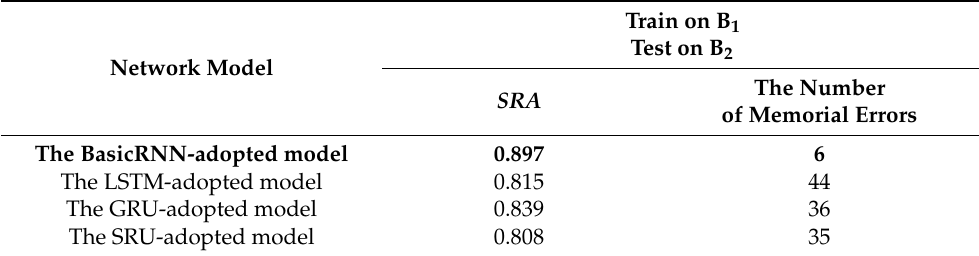
Table 5. The test results of the BasicRNN-adopted model, the LSTM-adopted model, the GRU- adopted model and the SRU-adopted model on B.